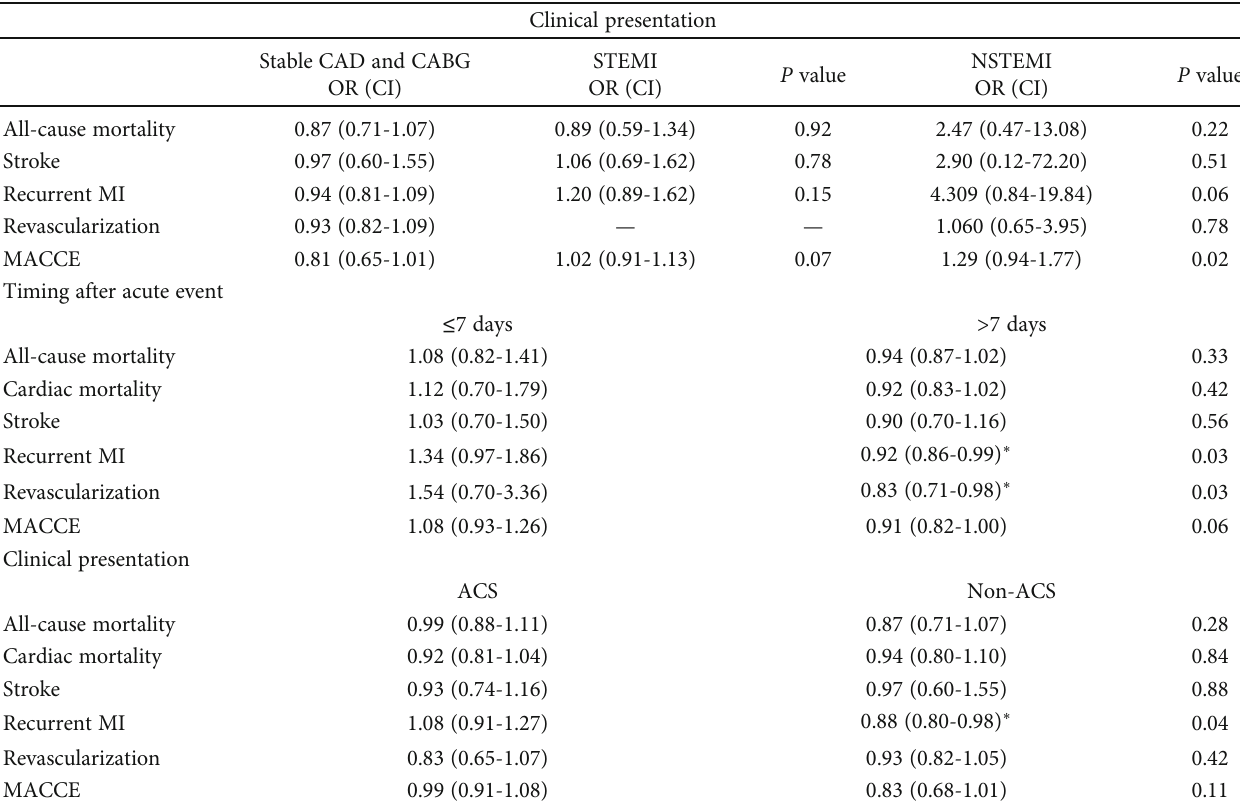
Table 3: Subgroup